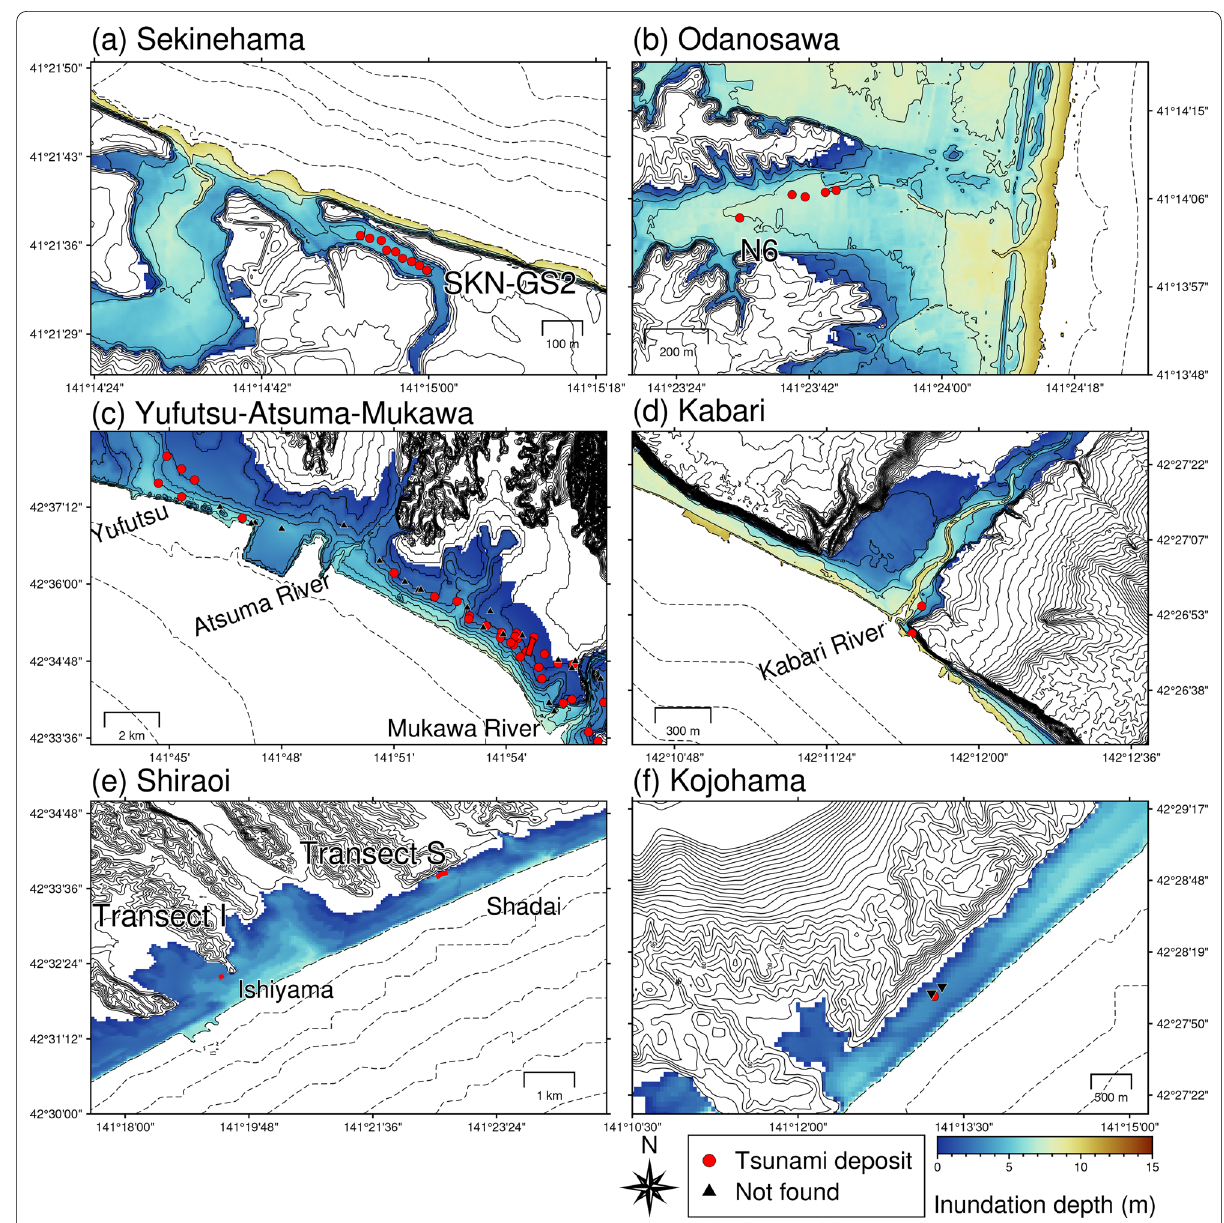
Fig. 7 Computation results using the S2 model with an 18 m slip. Comparison computed inundation area with tsunami deposit distributions reported by previous studies: a Sekinehama (Ishimura et al. 2022), b Odanosawa (Tanigawa et al. 2014), c Yufutsu–Atsuma–Mukawa (Takashimizu et al. 2007), d Kabari (Takashimizu et al. 2017), e Shiraoi (Nakanishi et al. 2014), f Kojohama (Nakanishi and Okamura 2019). The red circles and rectangle show their locations. The solid contour shows the topography, and the dotted contour shows the bathymetry (less than 0 m). The topographic contour intervals are 1 m in ( c ), 2 m in ( a ), ( b ), and ( d ), and 10 m in ( e ) and ( f ). The bathymetric contour intervals are 2 m in ( a ), ( b ), and ( d ) and 10 m in ( c ), ( e ), and ( f ). The red line (right) and square (left) in e show the tsunami deposit distribution limits in transects S and I, respectively, found by Nakanishi et al. (2014). The red circle in f represents the most inland “sand layer” site in “Line KJH” investigated by Nakanishi and Okamura